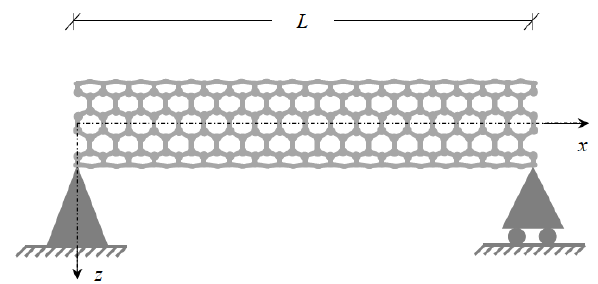
Figure 1: A typical simply supported carbon nanotube